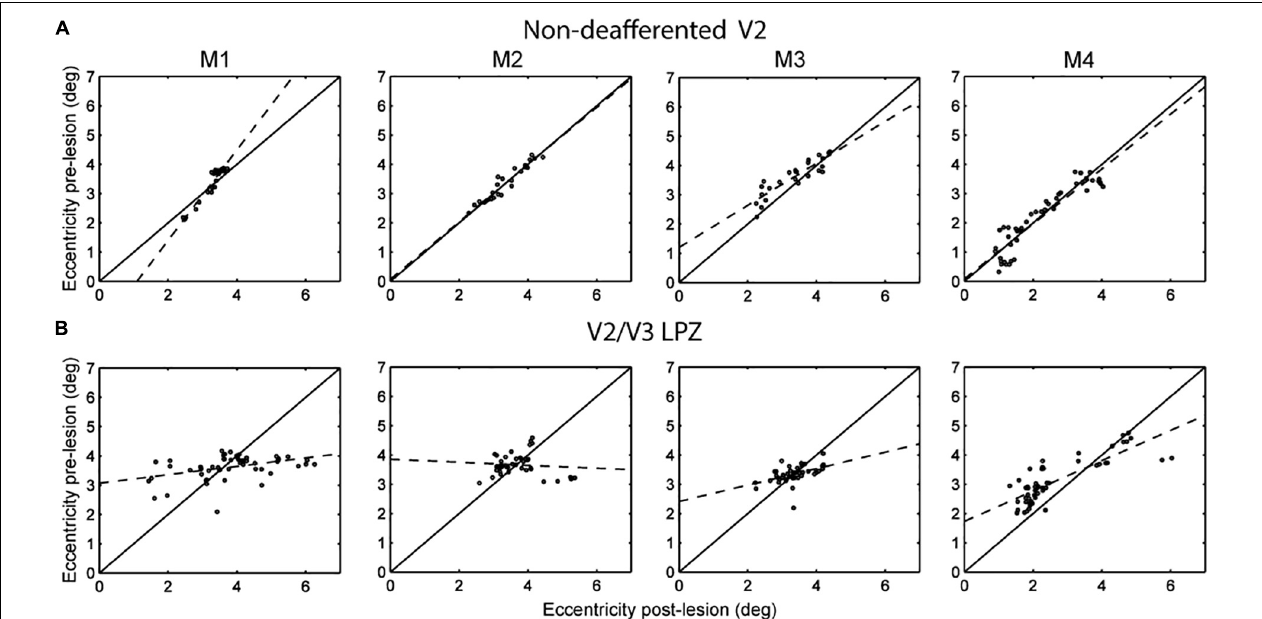
FIGURE 5 | Eccentricity profile of V2/V3 LPZ. (A) Scatter plots of pre-lesion vs. post-lesion (day 14) eccentricities of voxels inside a control, non-deafferented, area V2 ROI (see Figure 2 ) near the V2/V3 LPZ border. Note that the eccentricities were mainly unchanged pre- and post- lesion (control). (B) Similar scatter plots of the voxels belonging in the dominant (largest) V2/V3 LPZ of each monkey. Note that eccentricities inside the LPZ span a wider range following the lesion, with eccentricities that started low tending to become lower and eccentricities that started higher tending to become higher. This suggests that lateral inputs are likely responsible for the activation of the V2/V3 LPZ